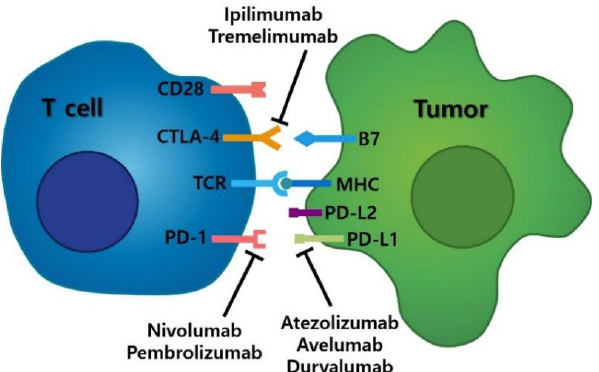
Figure 2. Checkpoint inhibition with PD-1, PD-L1, and CTLA-4 blockade . Table 4. FDA-approved checkpoint inhibitors.